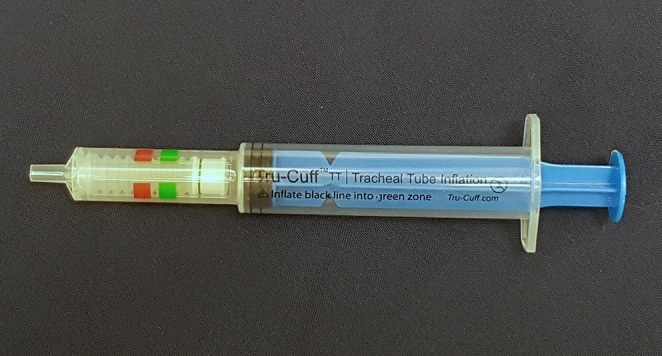
The Tru-CuffTM syringe has green (18–26 cmH2O) and red color (40–60 cmH2O) zones indicating different ETT cuff pressure ranges.